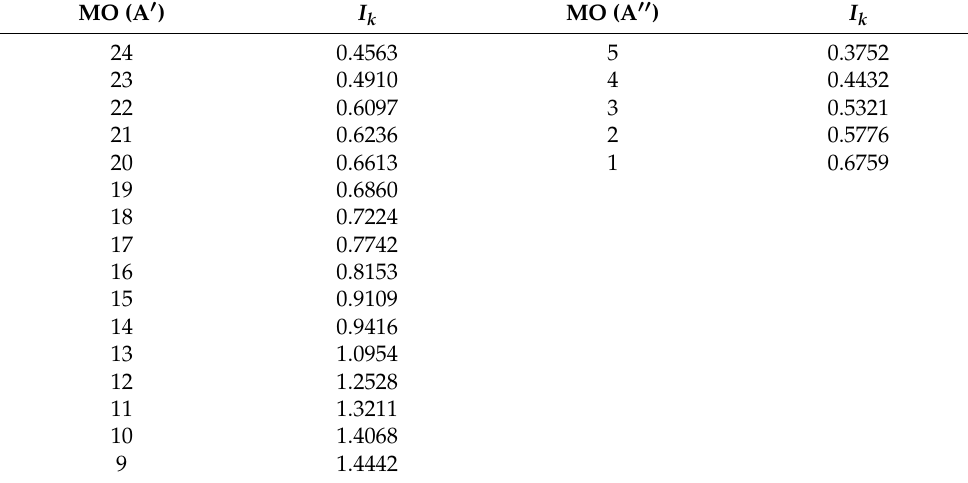
Table 2. Molecular orbital ionization energies (in Hartree) of uracil at the Hartree–Fock level, I k . A (cid:48) MO from 20 to 24 and all A (cid:48)(cid:48) are used in the CTMC calculations, while A (cid:48) orbitals from 9 to 19 are only used to compute the final CTMC cross sections.